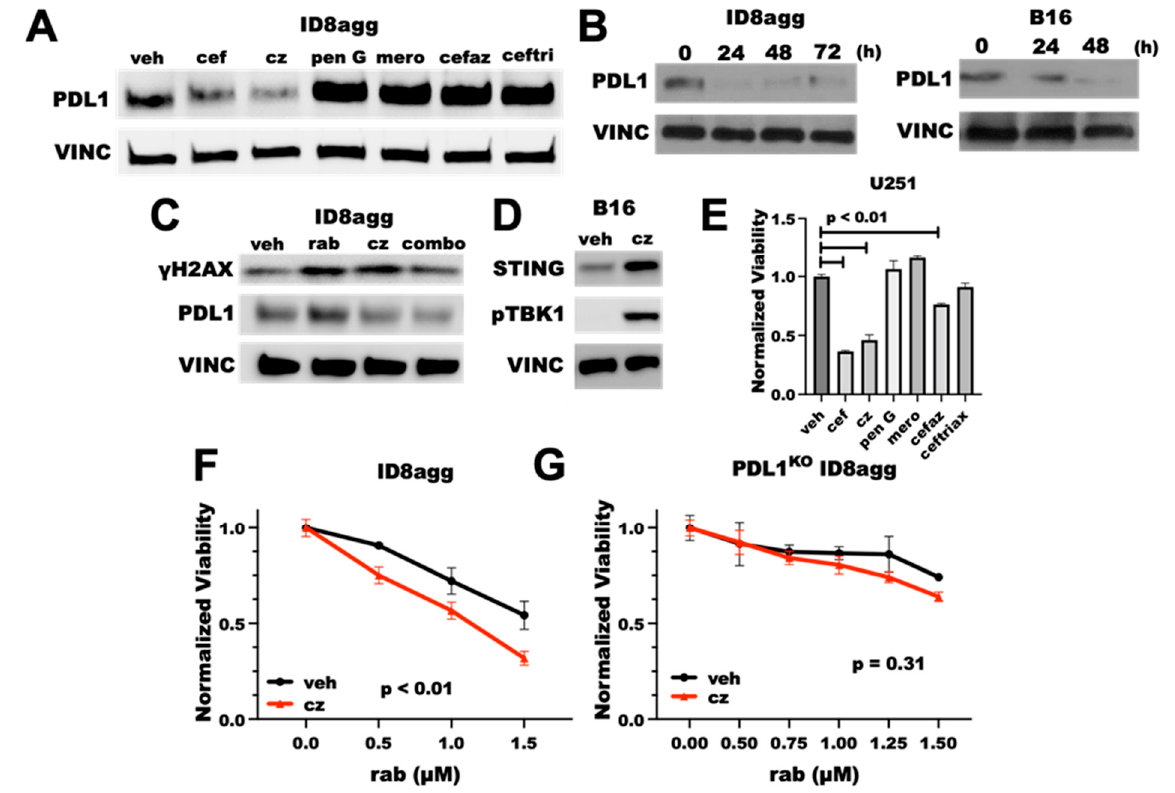
Figure 7. Tumor PDL1depletion effects of cefepime are likely independent of the β -lactam ring. ( A ) Immunoblot of PDL1 and loading control vinculin (VINC) of ID8agg cells treated with DMSO (veh) or 80 μ M of β -lactam antibiotics cefepime (cef), ceftazidime (cz), penicillin G (pen G), cefazolin (cefaz), ceftriaxone (ceftri), and the carbapenem meropenem (mero) for 48 h. Drugs were replenished daily. ( B ) Immunoblot for PDL1 and loading control vinculin of ID8agg and B16 cells treated with ceftazidime for indicated time points, replenished daily. ( C ) Western blot for γ H2AX, PDL1, and loading control vinculin of ID8agg treated with DMSO, 2.5 μ M rabusertib (rab), 80 μ M ceftazidime, or combination for 72 h. ( D ) Immunoblot of B16 cells treated with DMSO or ceftazidime for 24 h for STING, phospho-TBK1, and loading control vinculin. ( E ) MTT viability of U251 cells treated with 80 μ M of β -lactam antibiotics cefepime, ceftazidime, penicillin G, cefazolin, ceftriaxone, and the carbapenem meropenem for 96 h. p values by unpaired t test. ( F ) MTT viability assay of ID8agg cells treated with rabusertib (rab) with DMSO or 80 μ M ceftazidime for 96 h. p value by two-way ANOVA. ( G ) MTT viability of PDL1 KO ID8agg cells treated with rabusertib, DMSO, or 80 μ M ceftazidime for 96 h. p value by two-way ANOVA.